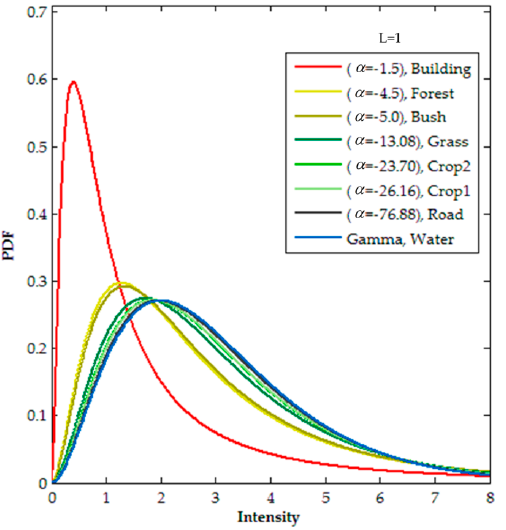
Figure 2. The theoretical probability density function (PDF) of each simulated class.